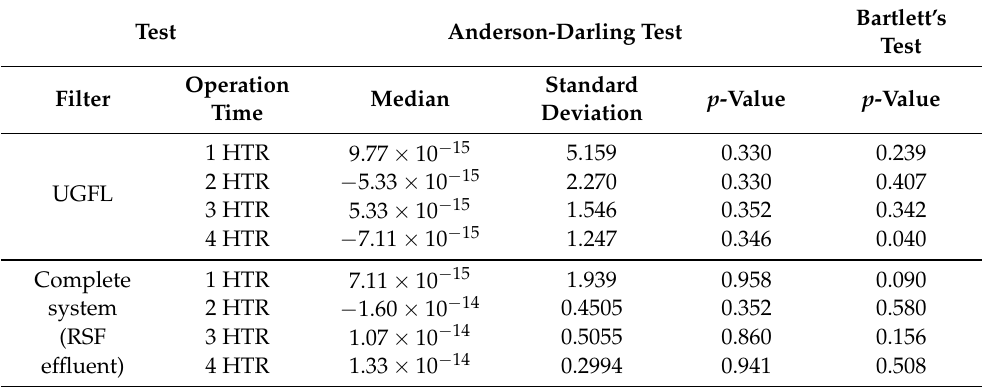
Table 6. Results of the normality and equality of variance